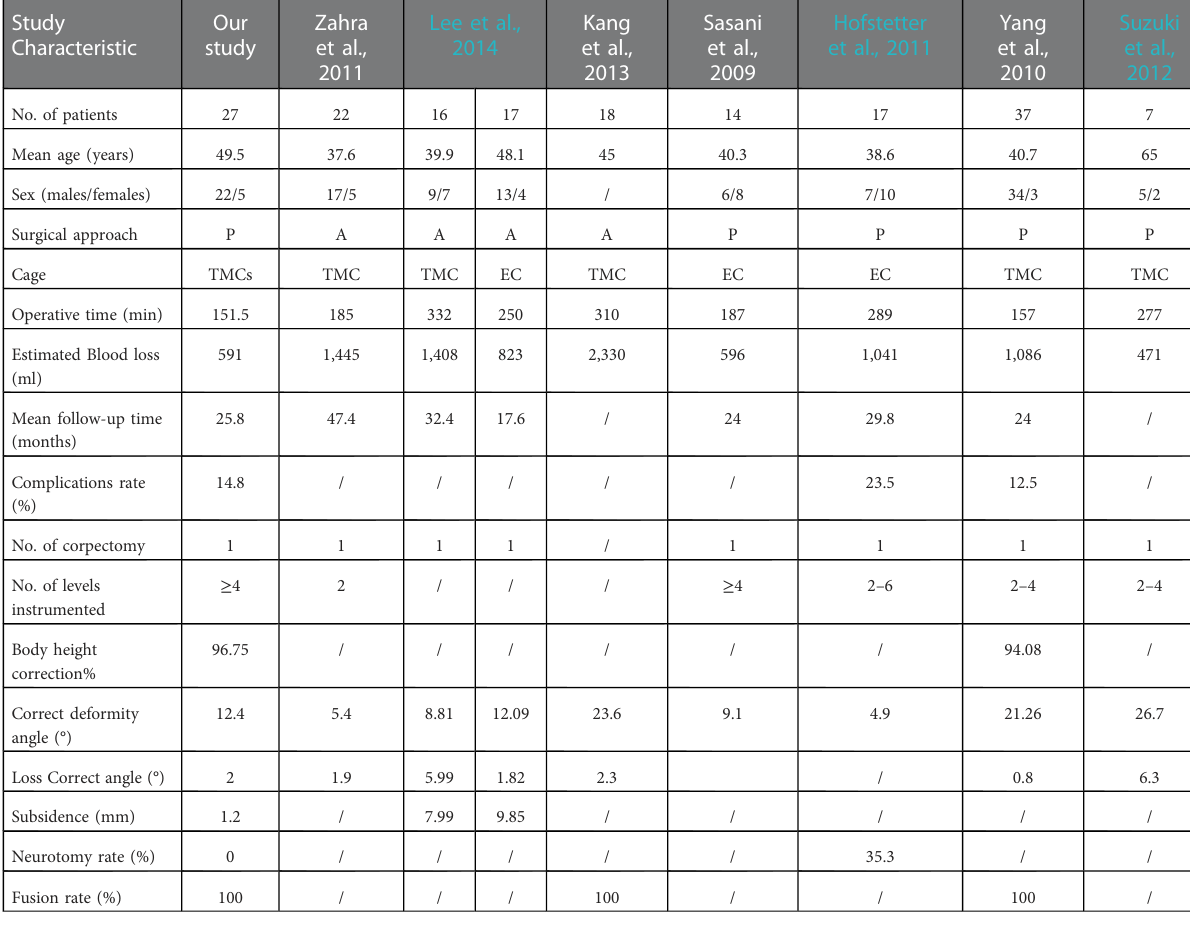
TABLE 3 Comparison of different studies in treatment for thoracolumbar burst